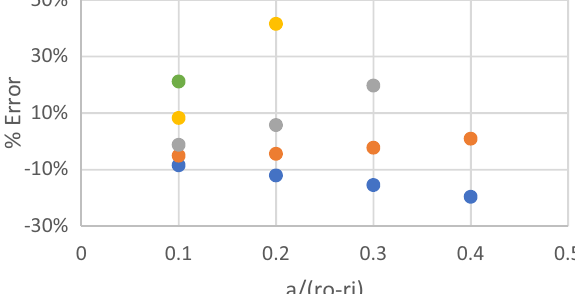
Fig. 19 Error in stress intensity factors for pressure vessel configura- tion